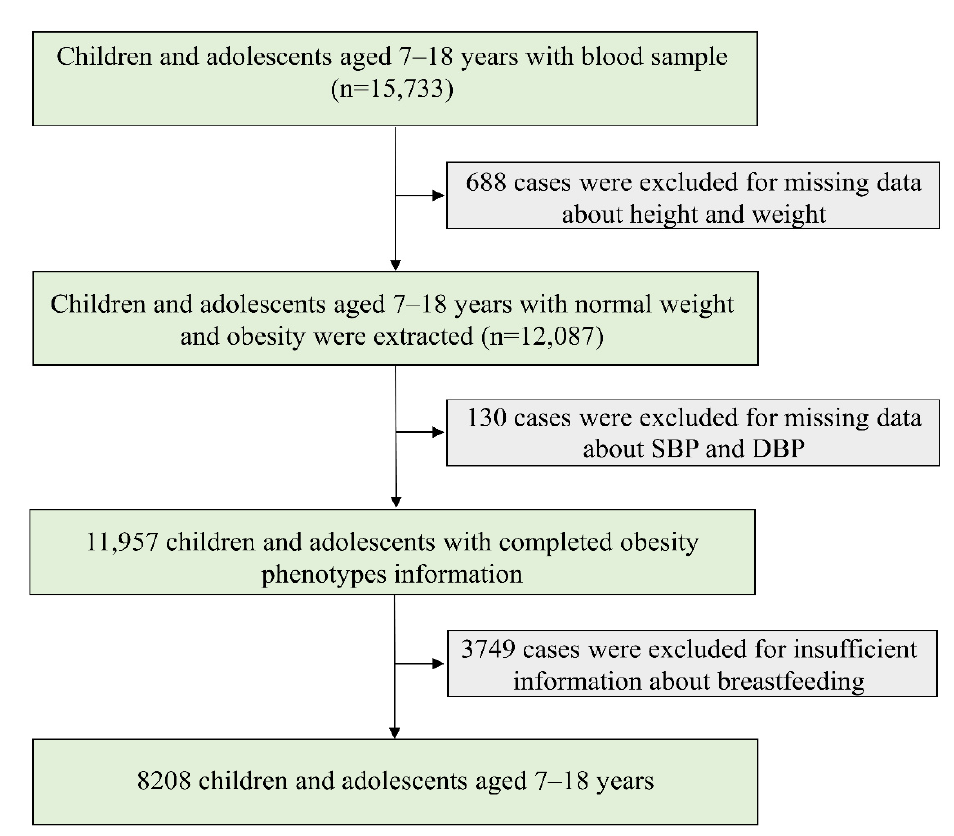
Figure 1. Flow chart of data. SBP, systolic blood pressure; DBP, diastolic blood pressure.